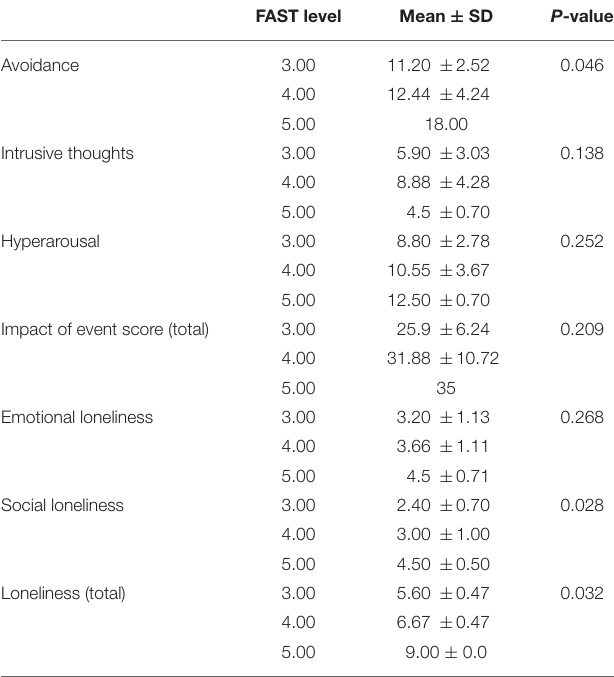
TABLE 5 | Relationship of cognitive impairment with impact of event and loneliness